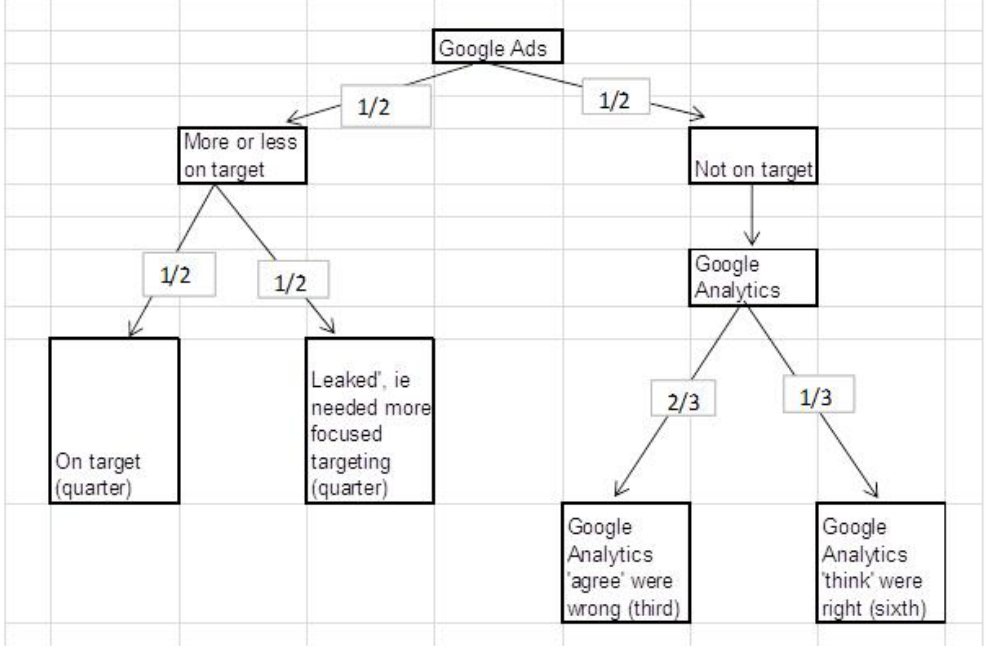
Figure 5. Approximate model explaining how the data we collected are